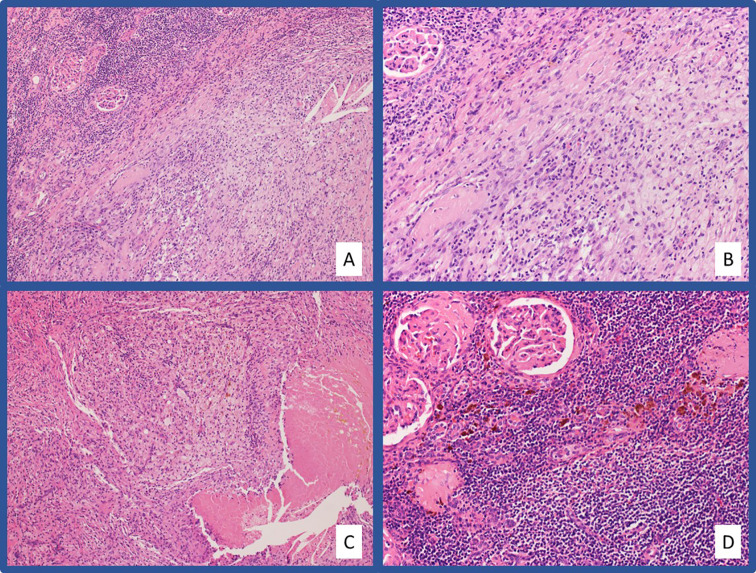
Representative pathologic images from Case #2 H&E stained slides at low-power (A) and high-power (B) magnification showing a massive infiltration of chronic inflammatory cells and foamy macrophages in the area of tumor regression. Areas of tumor regression also showed necrotizing granulomatous inflammation (C). Chronic tubulointerstitial nephritis, globally sclerosed glomeruli, and hemosiderin laden macrophages are present in the adjacent residual benign renal parenchyma (D).